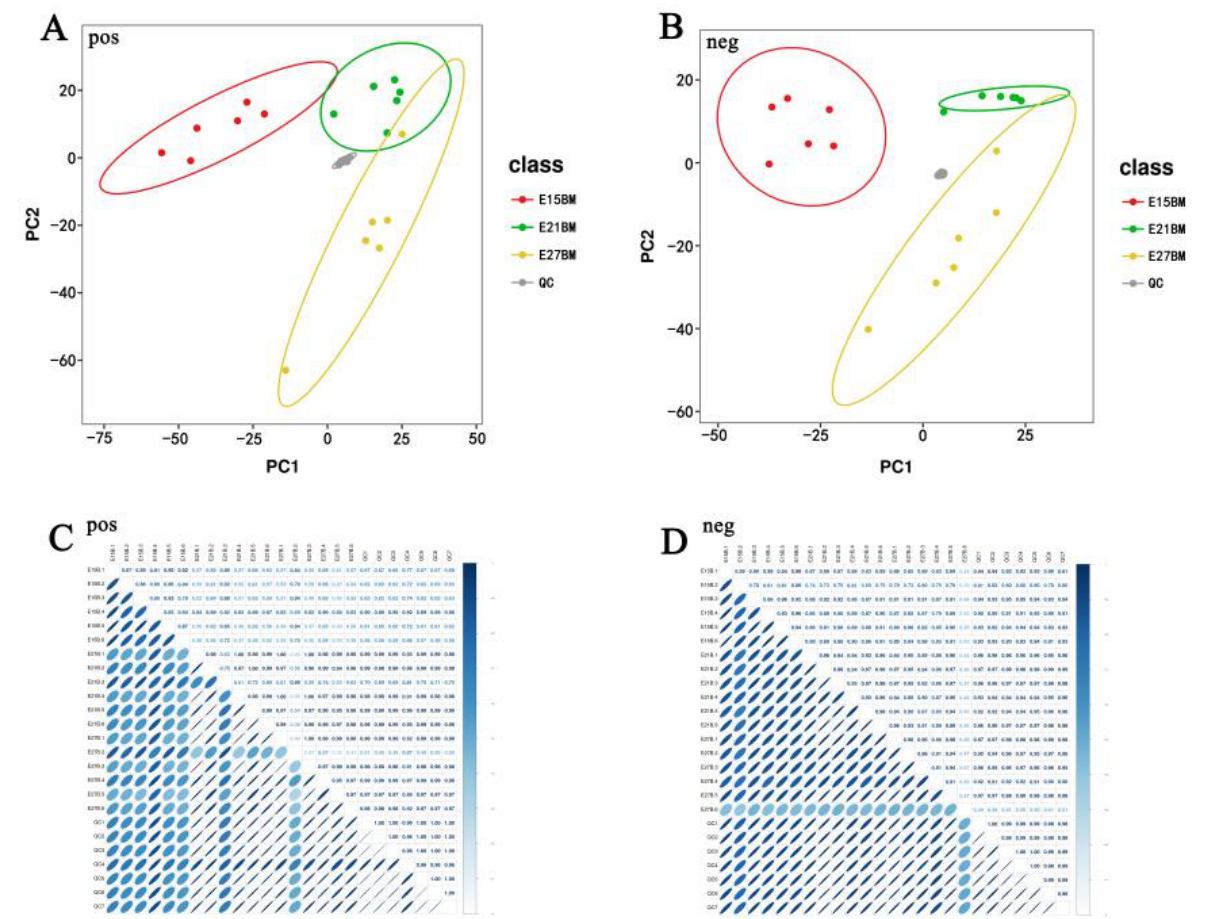
Figure 2. PCA analysis and Pearson’s correlation coefficients among samples. ( A , B ) PCA analysis; ( C , D ) Pearson’s correlation coefficients. Note: E15_BM represents breast muscle of Pekin duck on day 15 of the incubation period. The same is shown below.